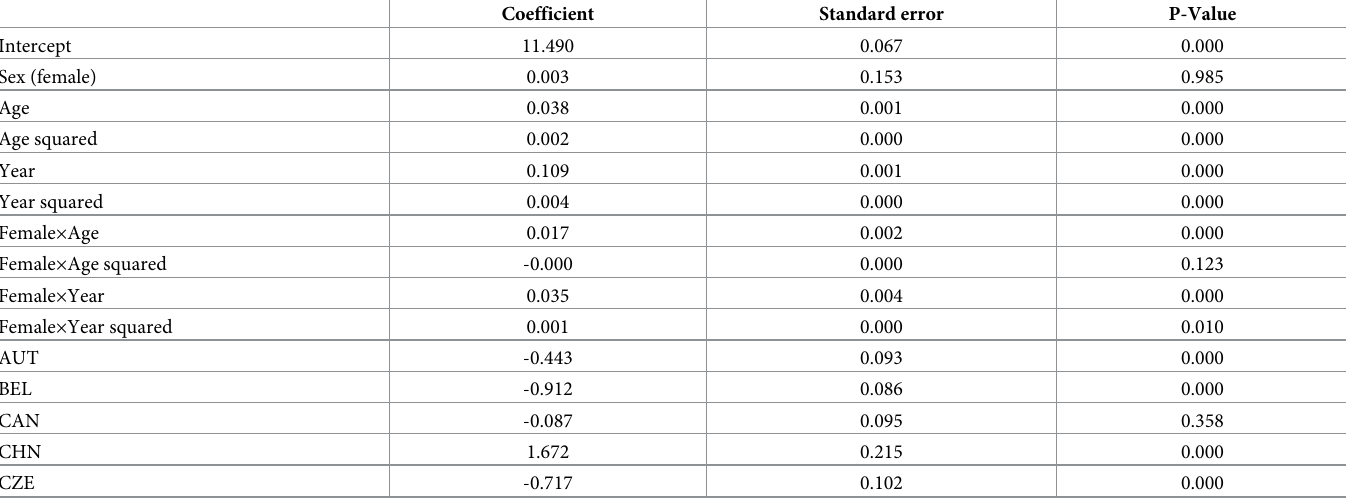
Table 12. Results from truncated regression with truncated dataset time = sex × (year+year 2 )+sex × (age+age 2 ) + sex × nationality and referenced to male, age 44, year 2009 and nationality Australia. R 2 =